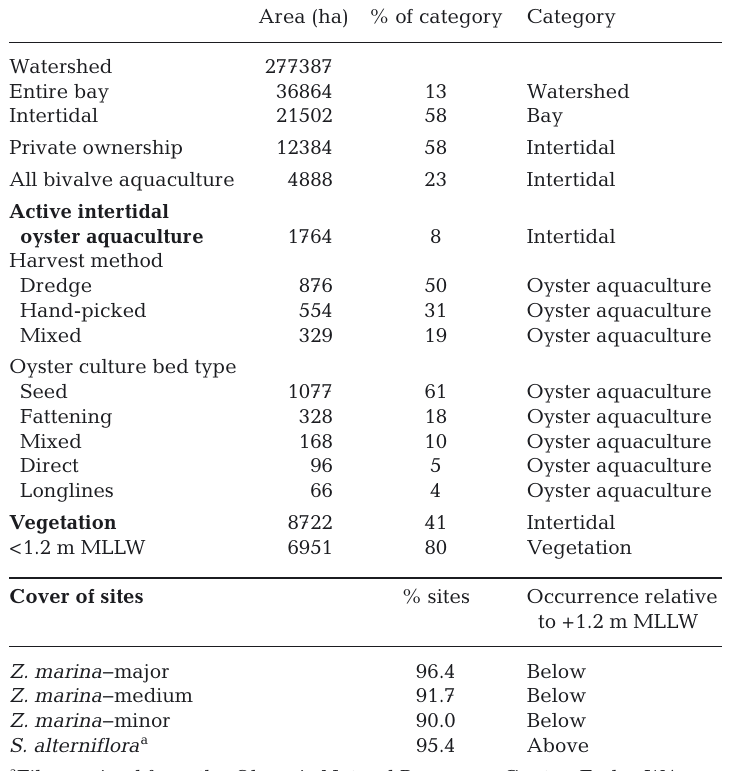
Table 1. Area statistics for Willapa Bay estuary. Active intertidal oyster aqua- culture excludes clam beds, seed racks, subtidal beds, and partially active beds. Vegetation includes all vegetation signal between −1.5 m and +3.2 m mean lower low water (MLLW) and includes some Spartina alterniflora , dense Zostera japonica , and Z. marina in pools at higher elevation, calculated using the mean of the summed probabilities from 2005, 2006, and 2009. Percentages of sites occurring at, below, or above 1.2 m MLLW are given for 4238 ground survey sites with 3 different densities of Z. marina cover and for mapped